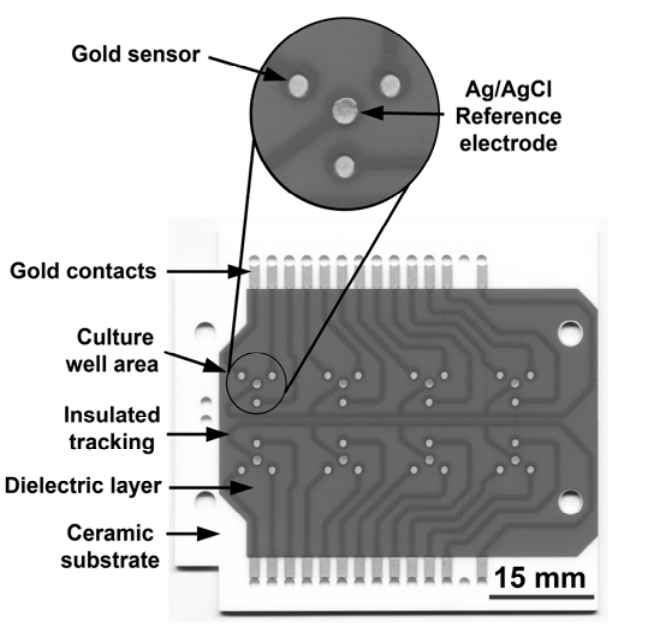
Figure 2. Disposable ceramic probe featuring gold sensors/tracking/contacts, reference electrode and insulating dielectric layer.